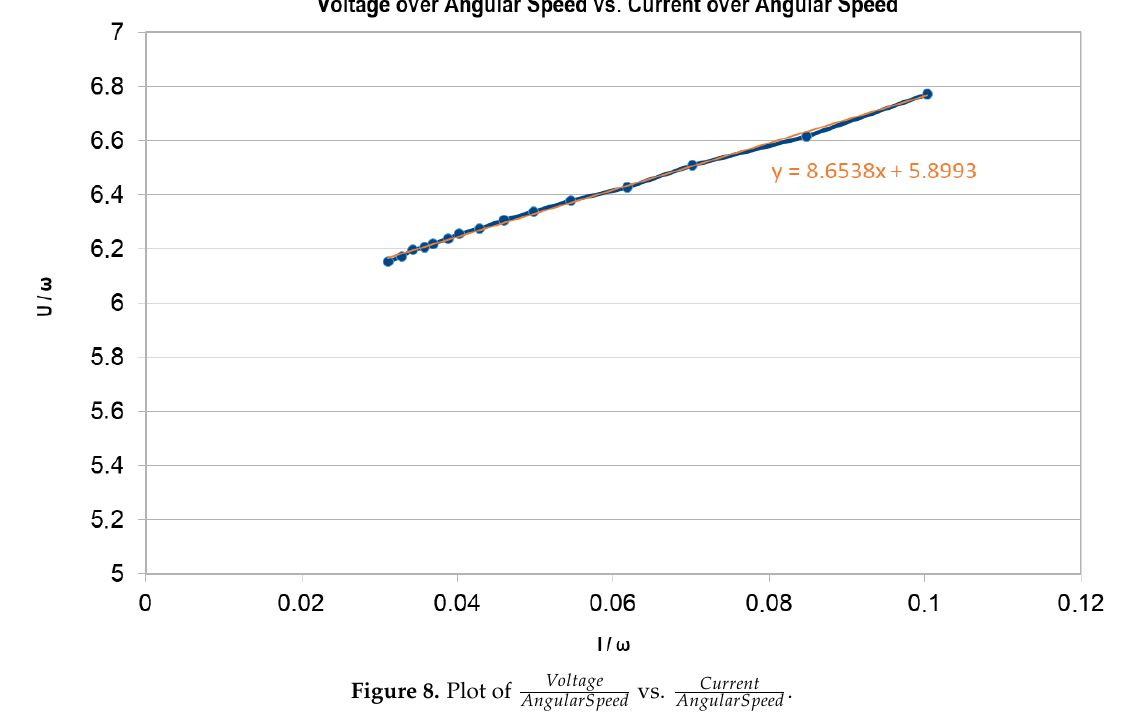
vs. Current . AngularSpeed AngularSpeed